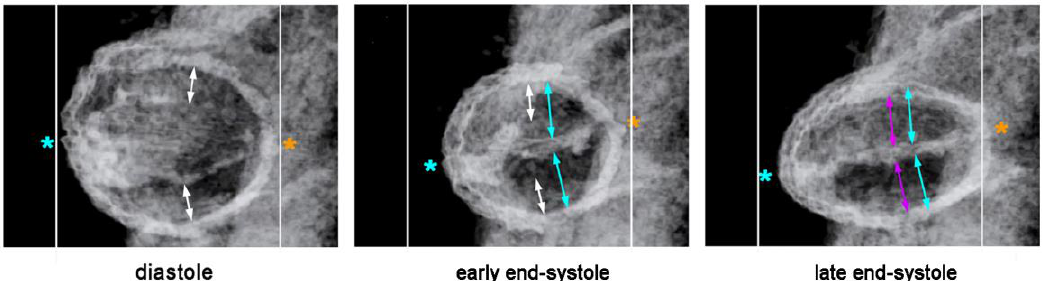
Figure 12. These images obtained by 4-dimensional in vivo OCT imaging of a HH-stage 15 embryonic chick heart depict the peculiar phenomenon of end-systolic stretching of the cross section of the ventricular bend along the original dorso-ventral axis. Asterisks mark the original ventral (light blue) and dorsal (orange) midlines, which are found along the outer and inner curvatures of the ventricular bend, respectively. Note the striking increase in the thickness of the CJ layer between diastole and early end-systole (indicated by white and blue arrows). Late end-systolic stretching of the cross section of the ventricular bend leads to a slight decrease in the CJ thickness (compare blue and magenta arrows). White lines mark the diastolic length of the original dorso-ventral axis.